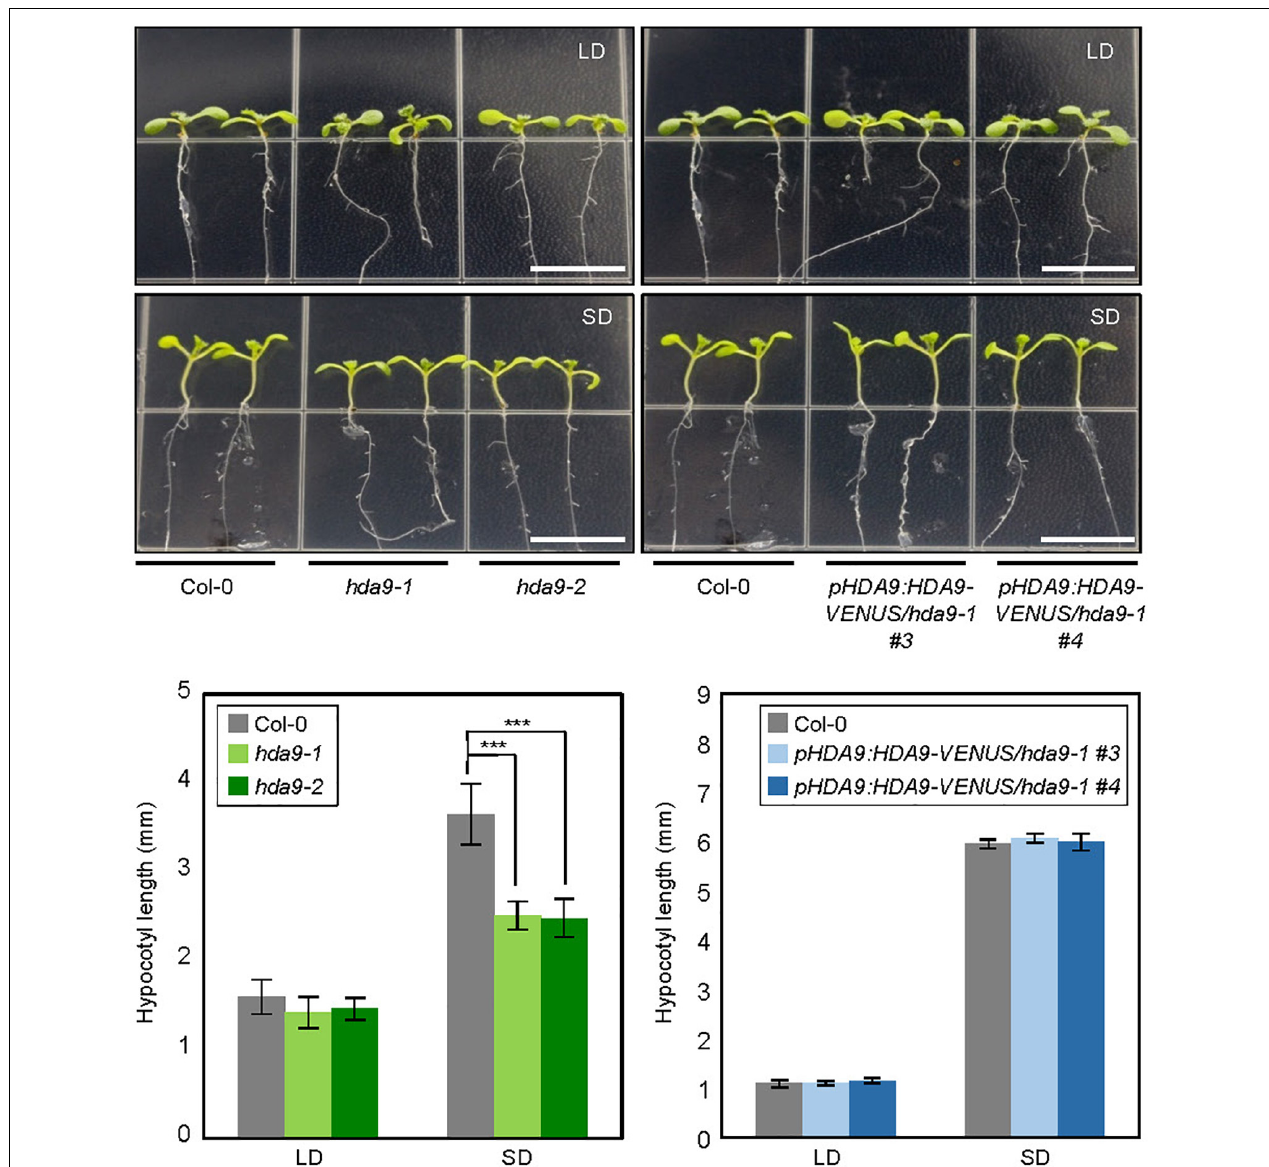
FIGURE 1 | Hypocotyl elongation phenotypes of hda9 mutants under short day (SD) photoperiod. Seedlings were grown under long day (LD) and SD conditions at 22 ◦ C, and hypocotyl length was measured for 7 days. At least 30 seedlings of each genotype were used in a single replicate, and values of three biologically independent replicates were averaged. Error bars indicate the standard error of mean (SEM). Statistical significance of the measurements was analyzed by Student’s t -test (*** P < 0.001). Scale bars = 1.0